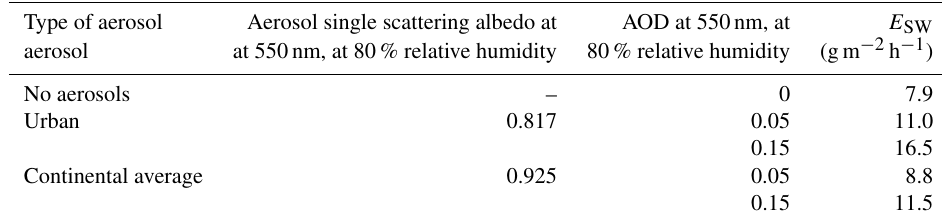
Table 4. Effect on E SW (defined in Sect. 2.1) by adding aerosols to the fog layer on 13 December 2015 at 12 UTC. Urban and continental average aerosols are defined as in Hess et al. (1998). The aerosol optical depth (AOD) is spread evenly across the 275m thick fog layer. Type of aerosol Aerosol single scattering albedo